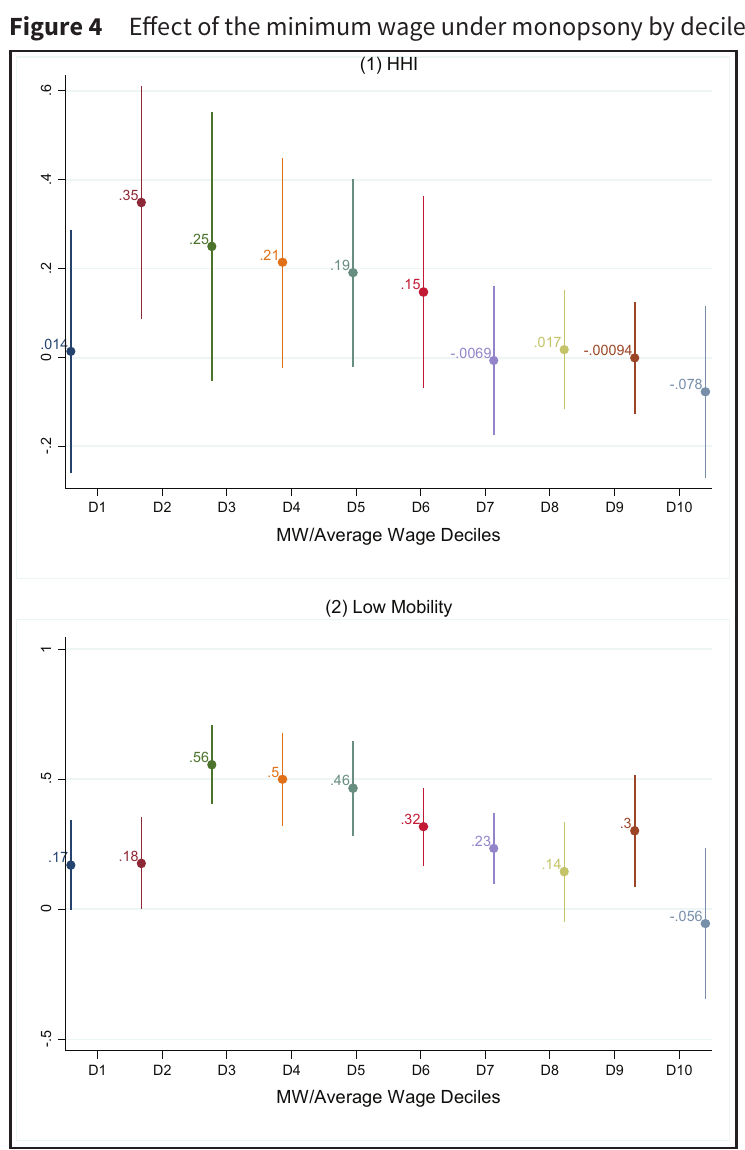
minimum wage. 10 The difference in the impact of minimum wage on employment between monopsonistic markets and competitive ones must be positive, regardless of whether the firms are demand- or supply-constrained. Thus, I expect a positive sign in the coefficient of the inter- actions. I estimate most of the results using two-way fixed effects to make them comparable with the existing literature. Finally, I also report the total effect of the minimum wage for dif- ferent values of the HHI (Figure 4). Figure 4 Effect of the minimum wage under monopsony by